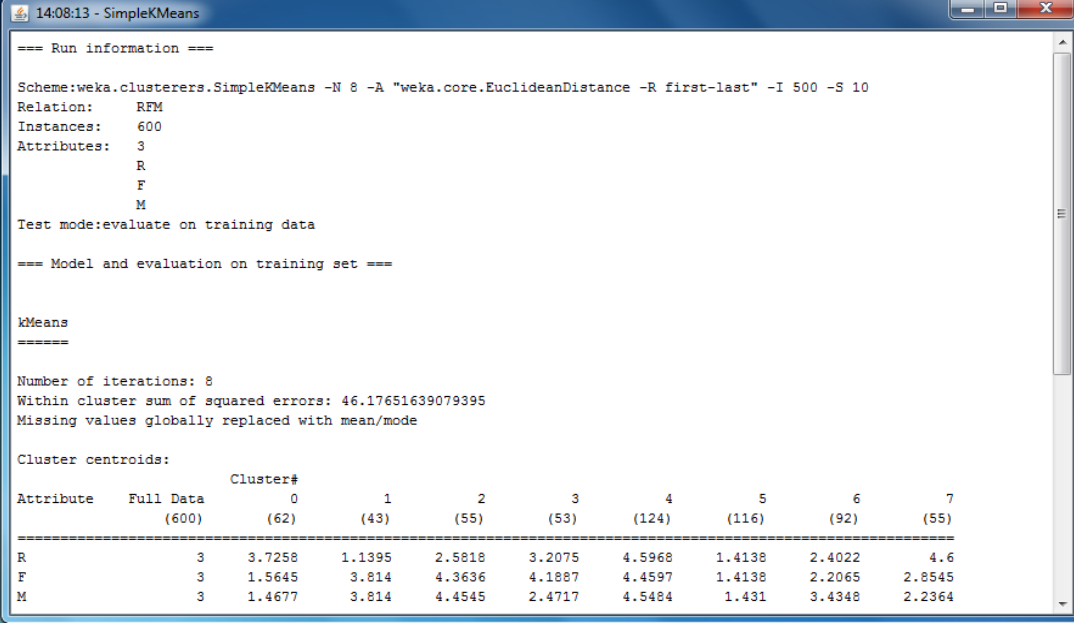
Figure 2. Scored RFM Clustering Result sand SSE for 12 month time frame from 1/1/2010 to 31/12/2010